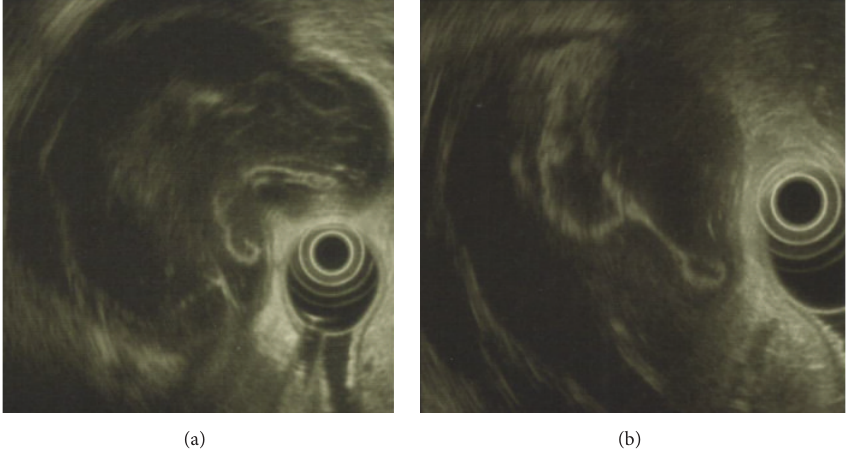
Figure 2: Heterogeneous lesion with a floating membrane inside.